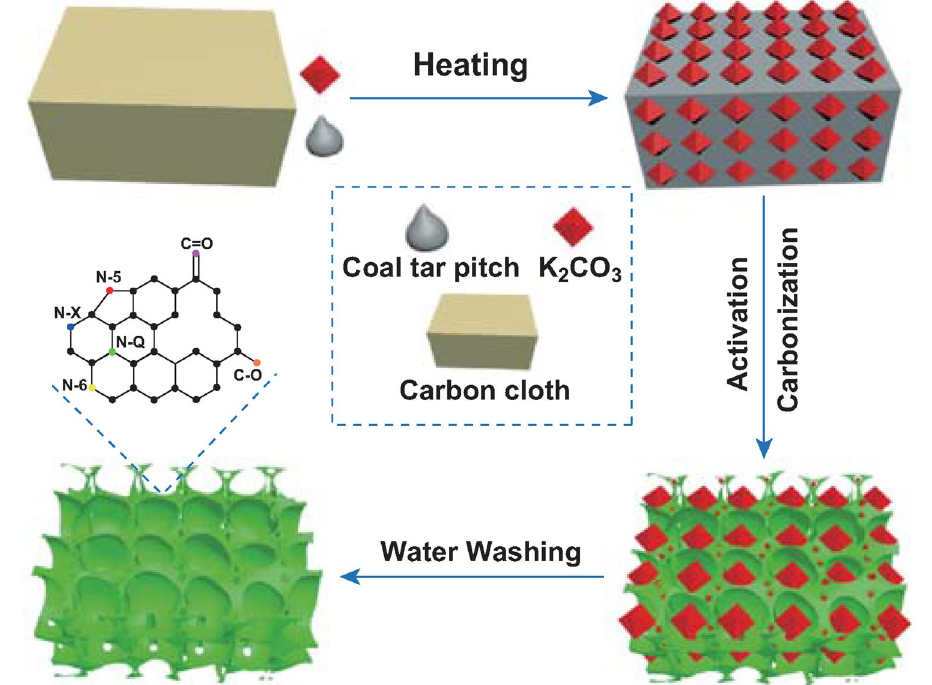
Fig. 3 Synthetic scheme of EBCs from CTP using carbon cloth as the directing template combined with in situ K 2 CO 3 activation